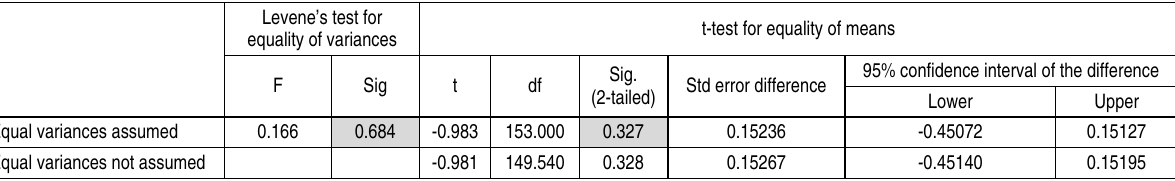
Table 6. Parametric hypothesis